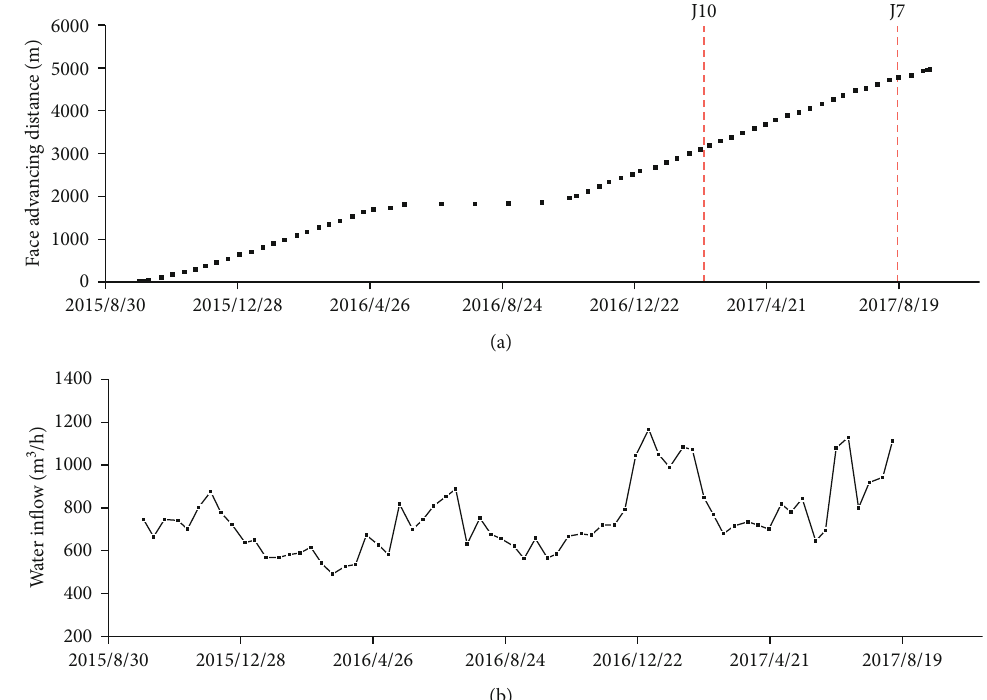
Figure 2: (a) S1229 panel advancing distance and (b) water in fl ow of entire coal fi eld. Red vertical dash lines show the times when the longwall excavation zone is closest to the J10 and J7 wells, respectively.